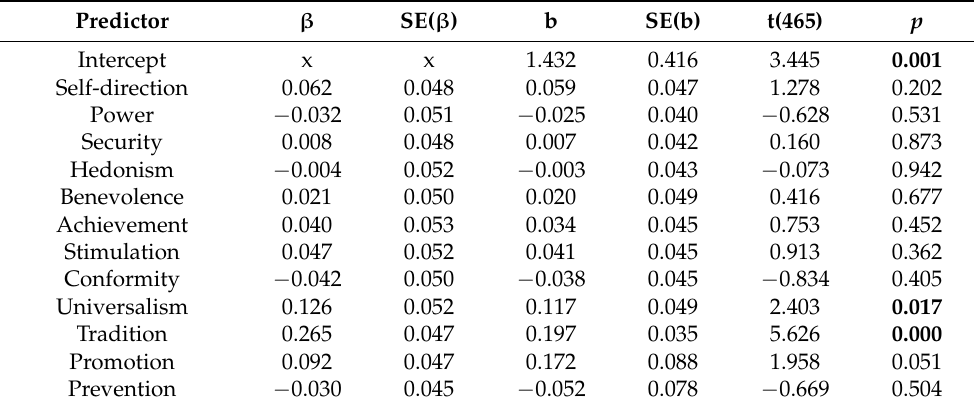
Table 9. The impact of the Schwartz values and regulatory focus on the WTP a price premium for domestic food products among men without control variables.